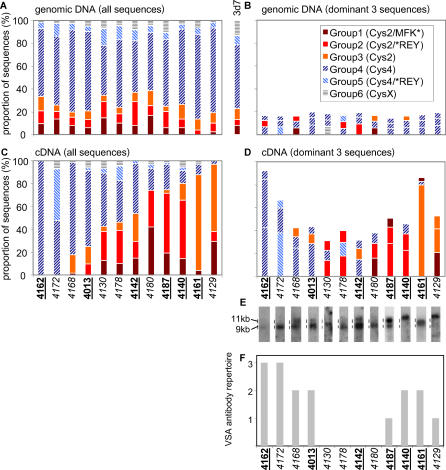

var Gene Expression Profiling(A–D) Each DBLα sequence was assigned to one of six sequence groups (Figure 3). The proportion of clones that fell into each of the six groups was calculated separately for genomic clones (A) and cDNA clones (C). (A) includes the distribution of sequences from the 3D7 genome (right). (B) and (D) show for each isolate the percent of genomic DNA (B) or cDNA clones (D) corresponding to the three most dominantly cloned genomic or cDNA sequences from that isolate. Isolates are ordered left to right according to the overall proportion of cys2 clones isolated from cDNA. Underlined ID numbers correspond to children with severe malaria.(E) Northern blots of total RNA from each of the parasite isolates. Blots were hybridized to a generic var exon 2 probe, varc, corresponding to a conserved region within all var genes. The position of var genes expressed by the laboratory parasite line Palo Alto is indicated by lines to the left of each lane. These are approximately 9 kb and 11 kb in length.(F) The VSA antibody repertoire carried at the time of acute disease by each patient. The y-axis shows the number of a panel of six parasite isolates that were recognised by the acute plasma from each child.